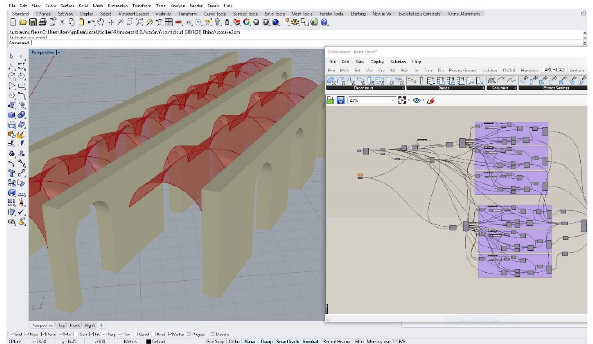
Figure 7: Grasshopper interface for morphology modelling of the